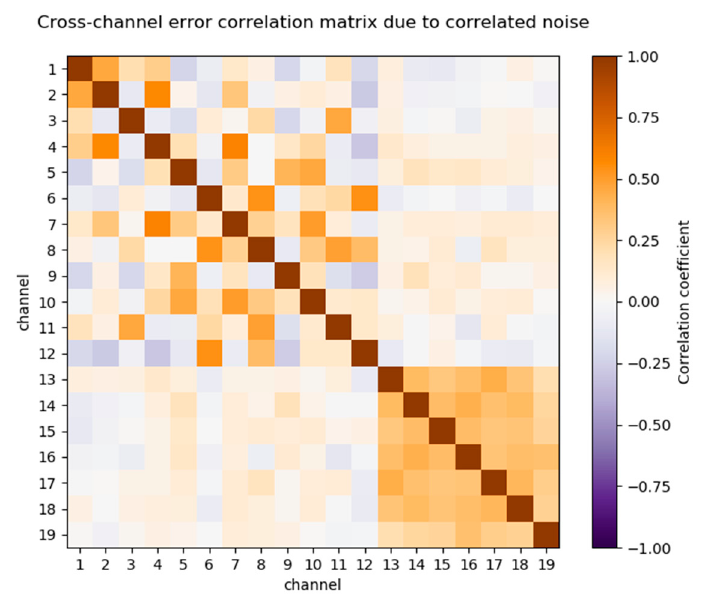
Figure 5. Cross-channel error correlation matrix, R c , from spatially independent effects, corresponding to data in Figure 1.